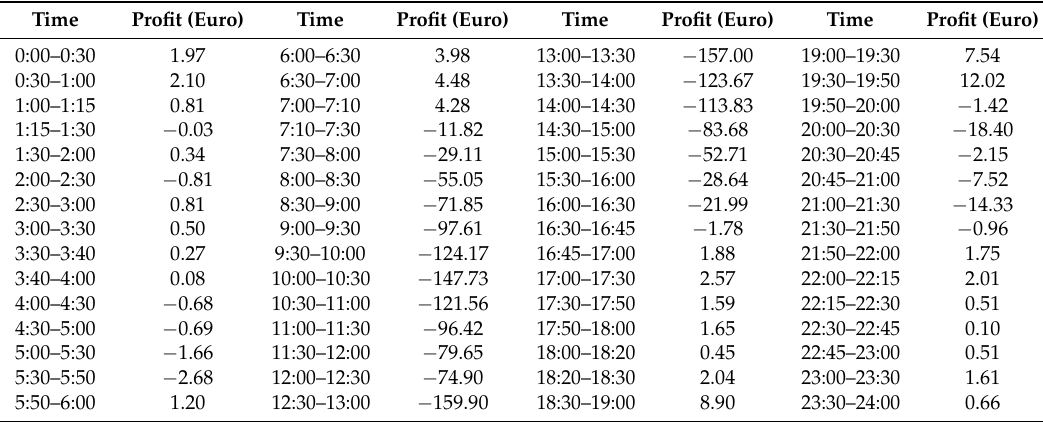
Table 3. Profit of the CHP using the day-ahead operation curve before